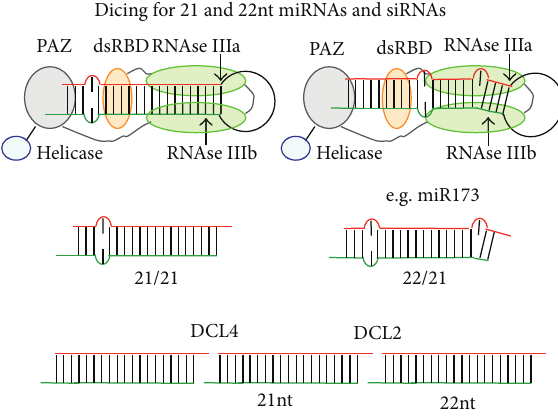
F 5: Differential susceptibility of RNAs for transitivity as such and for the direction of transitivity. (a) RDR and RNA-degrading enzymes compete for aberrant RNA. (b) Possible shielding of RNA from RDR activity by scanning and translating ribosomes.